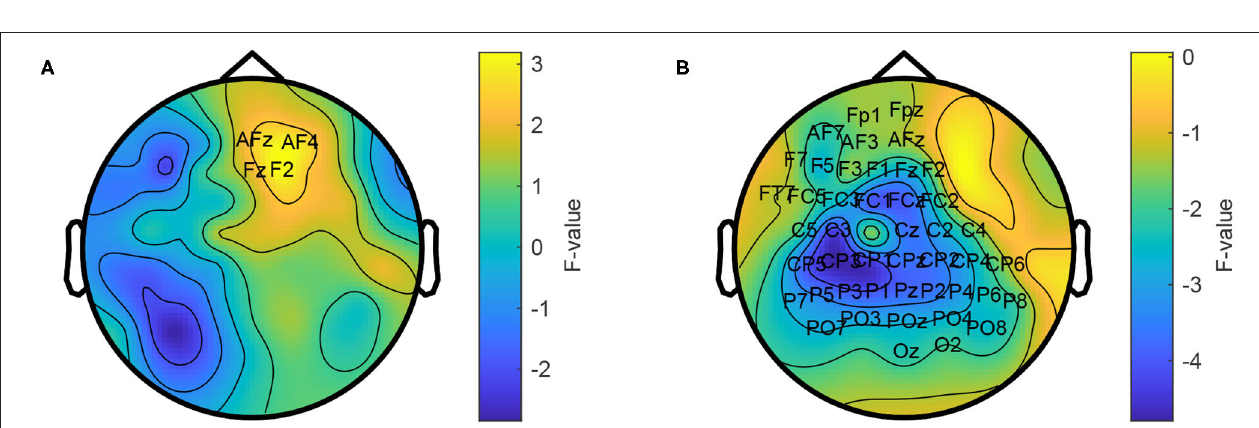
FIGURE 3 | Topographic comparison of power spectra in the collaborative and individual condition. Power in the frequency range from 66 to 120 Hz is stronger in the collaborative condition (A) and weaker in the range from 1 to 30 Hz (B) . The average power across the respective frequency ranges is shown. Labeled electrodes indicate statistically significant